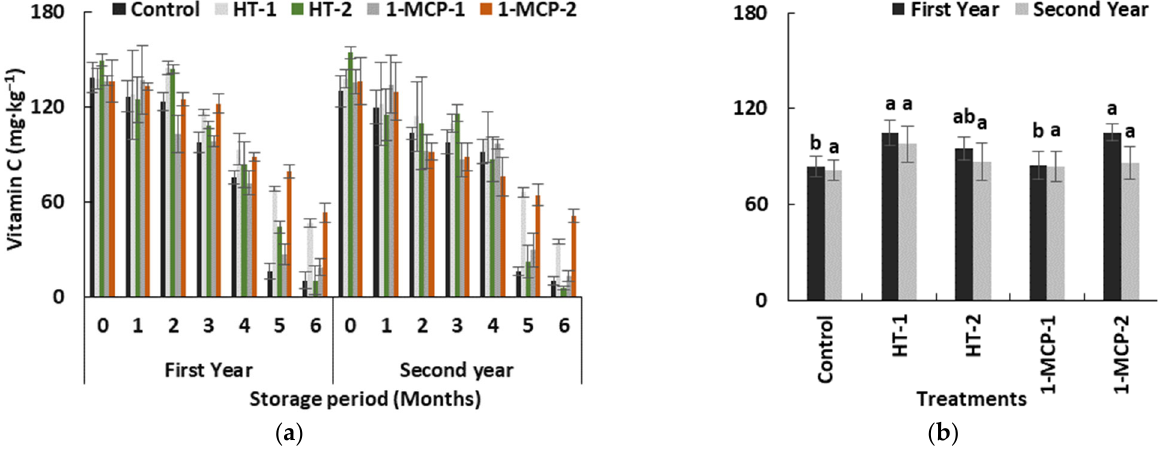
Figure 7. The effect of storage period of 6 months at 0 ± 1 °C temperature, 85–90% relative humidity and regular air conditions ( a ); and the effect of different postharvest treatments ( b ) on vitamin C content of quince fruit during long ‐ term cold storage. Control—without postharvest treatment; HT ‐ 1—Hot water treatment at 50 ± 1 °C for 3 min; HT ‐ 2—Hot water treatment at 50 ± 1 °C for 5 min; 1 ‐